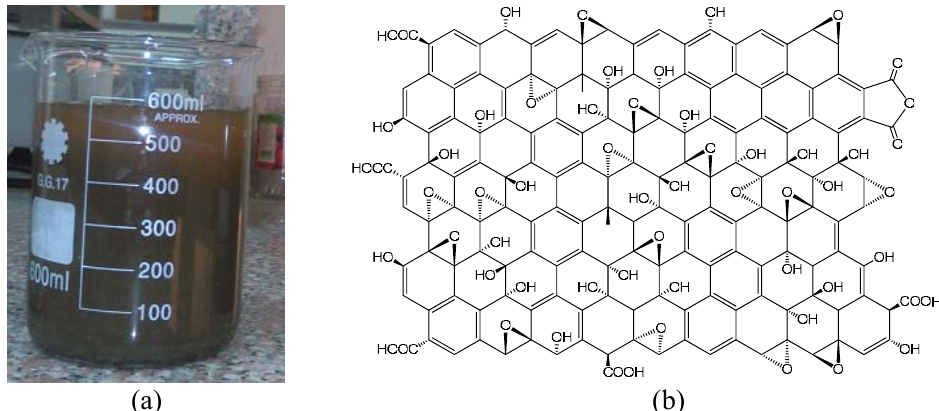
Fig. 1: (a) Photographic image of as-prepared GO solution (b) Proposed model of GO structure.